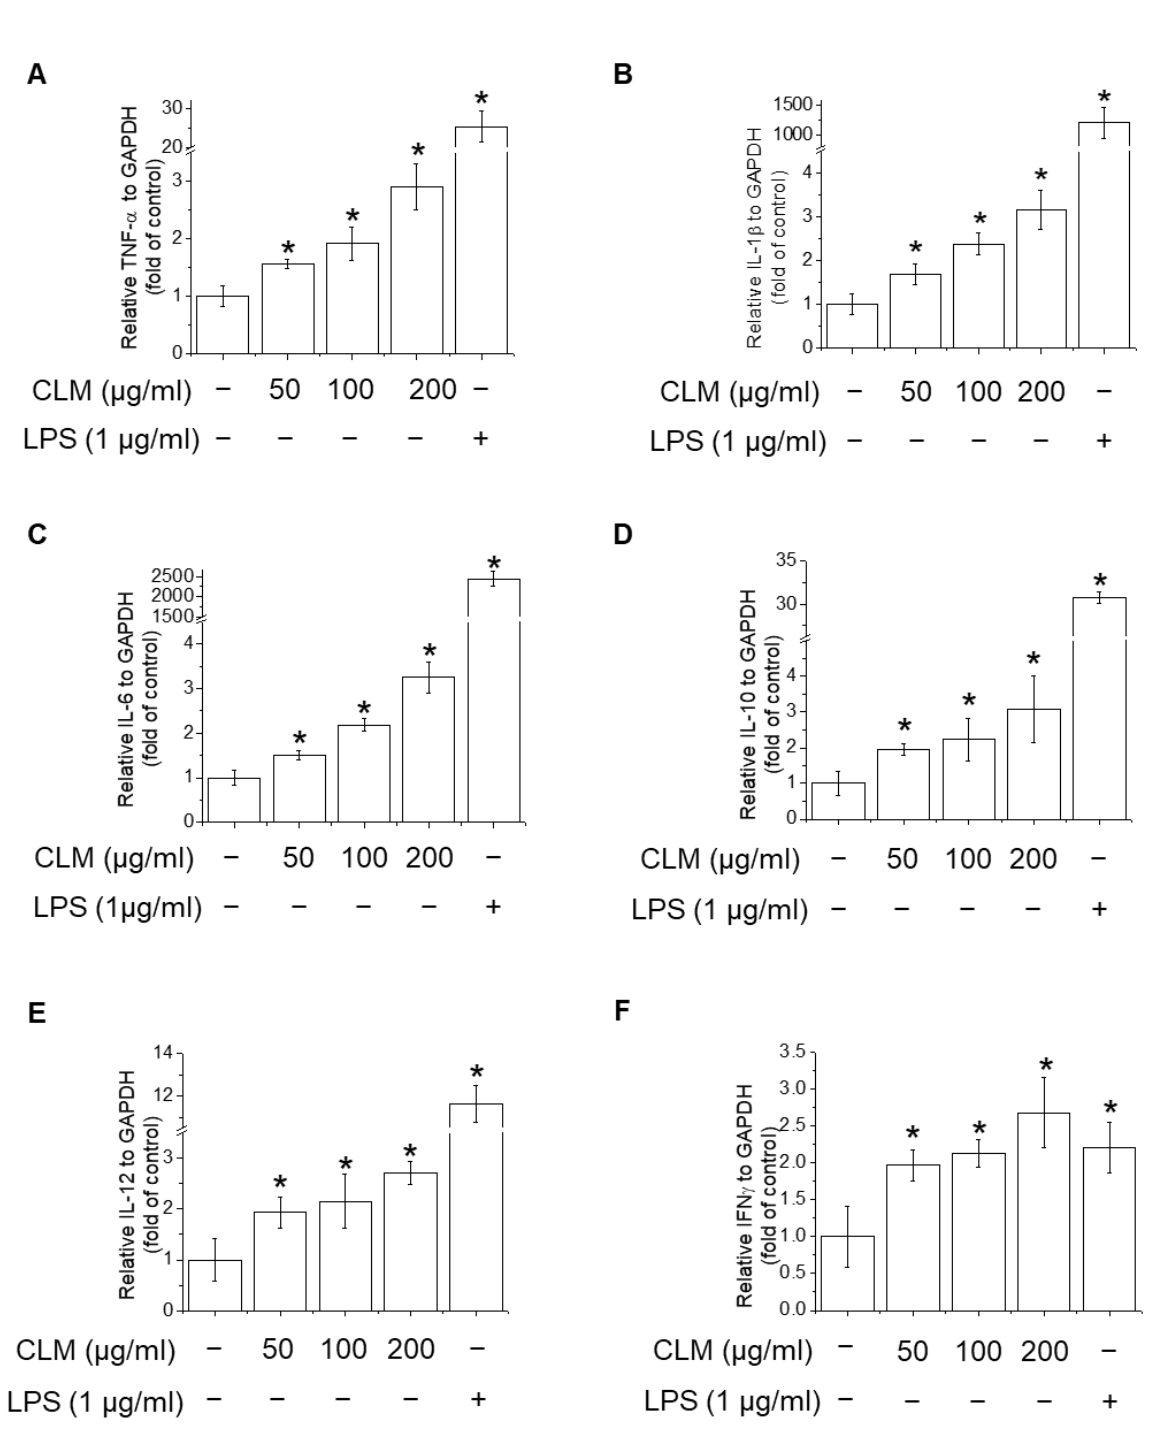
Figure 5. Effects of CLM on macrophage-related cytokine production in RAW264.7 cells. Cells were treated with various concentrations of CLM (50, 100, and 200 µ g/mL) for 6 h. mRNA levels of TNF- α , ( A ), IL-1 β ( B ), IL-6 ( C ), IL-10 ( D ), IL-12 ( E ), and IFN- γ ( F ) were measured by RT-PCR. * p < 0.01 vs. control group.